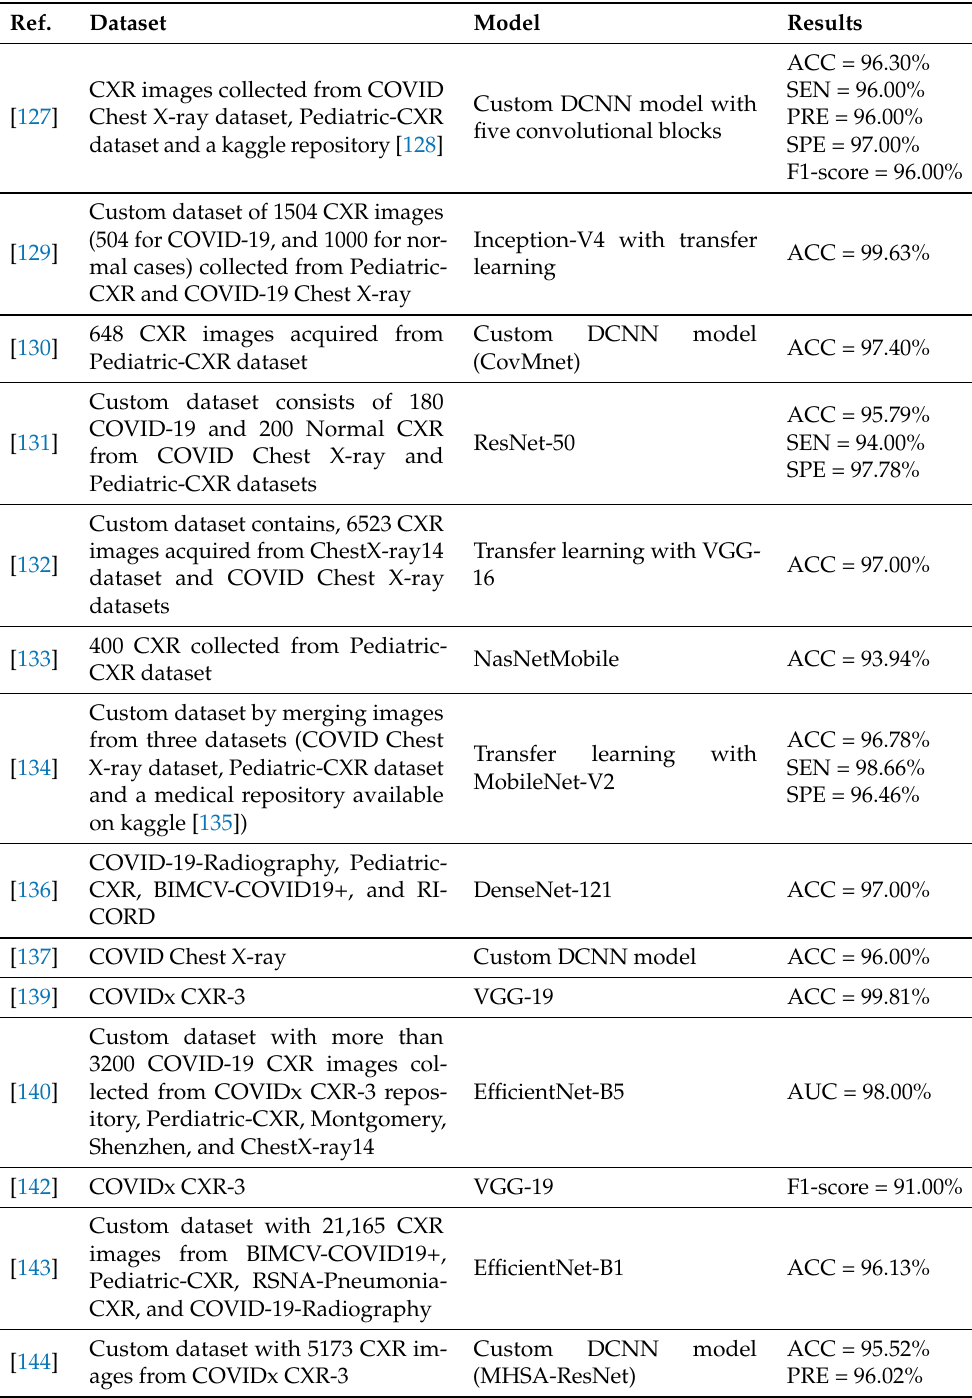
Table 10. Summary of different DL architectures for COVID-19